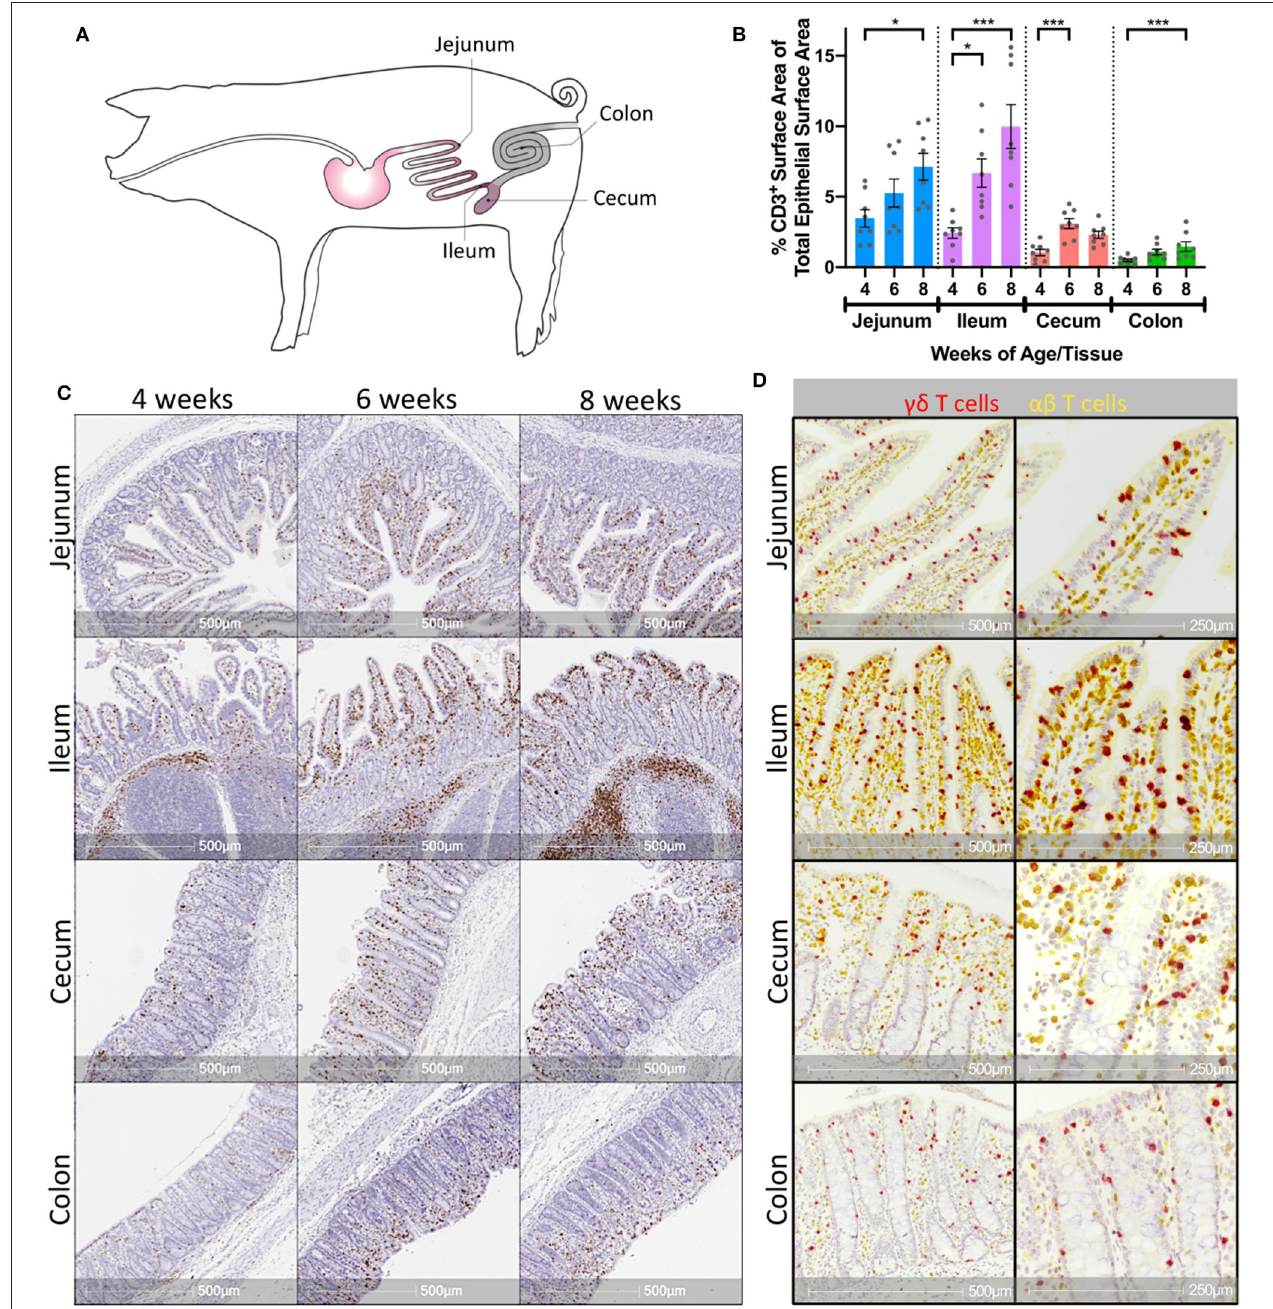
FIGURE 1 | Porcine intestinal IETs increased with age and were composed of γδ and αβ T cells. (A) Anatomical diagram of tissue collection sites from jejunum, ileum, cecum, and colon within pig intestinal tract. (B) Representative images of T cell-specific CD3 protein staining (brown) within multiple intestinal tissues at different ages in pigs. (C) Percentages of epithelial surface area stained for CD3 protein within a single tissue over multiple timepoints. Statistical significance was determined within a single tissue across timepoints by the rank-based Kruskal-Wallis test using all combinations of multiple comparisons within a tissue. P < 0.05 were considered significant (* < 0.05, *** < 0.001). (D) Representative images of T cell-specific CD3 protein staining (yellow) and γδ T cell-specific TRDC transcript staining (red) in pig intestinal tissues at 8-weeks of age. Distance scales on the bottom of each image are included for size comparisons. Samples were taken from 4 animals per timepoint in each of two separate experiments ( n = 8 per timepoint; n = 24 total).